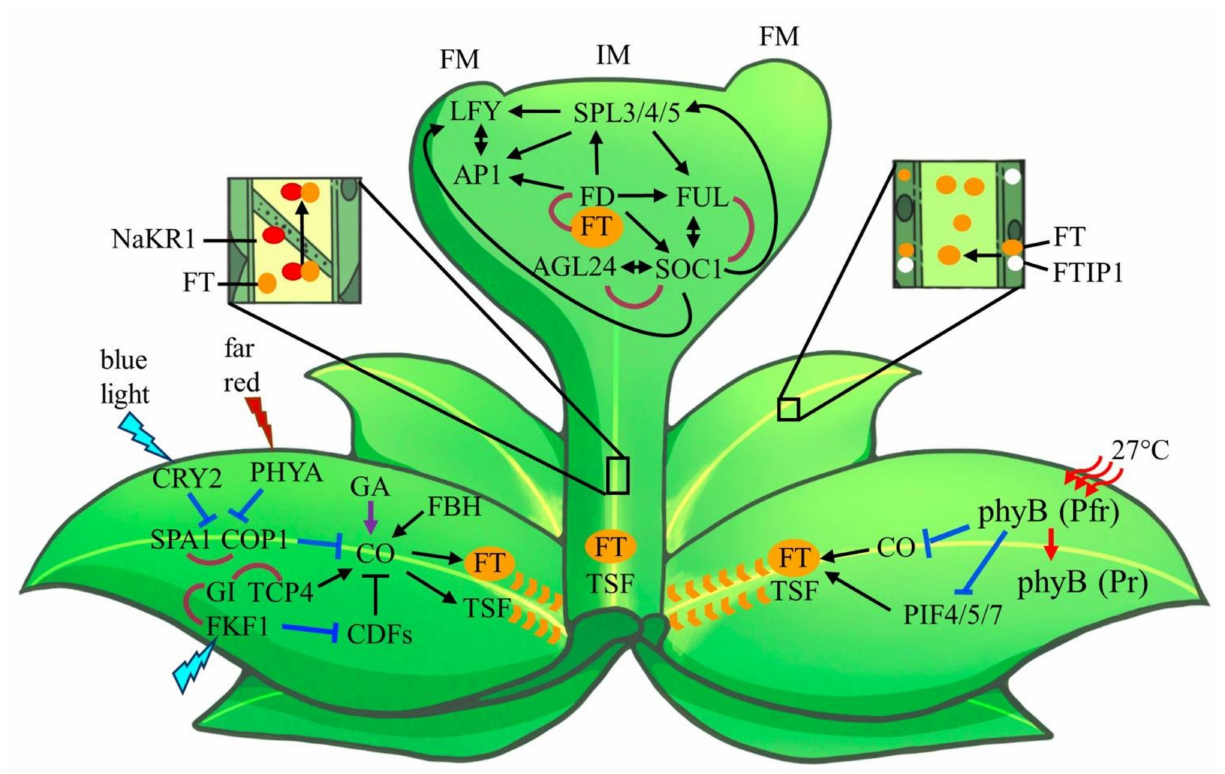
Figure 3. Flowering induction in response to LD photoperiod and high temperature. The transcriptional (black lines) and posttranslational regulation (blue lines) of CO mediates FT expression. phyA and cry2 promote CO protein’s stability, while phyB in its active state (Pfr) inhibits it. Thermal reversion of the latter favors the accumulation of CO and PIFs to induce FT . The FT protein travels through the phloem with the help of FTIP1 and NaKR. Once FT reaches the apical meristem, it associates with FD to induce some MADS-box genes, (including AP1 ) and SPLs that upregulate LFY and AP1 . Magenta curve lines represent protein